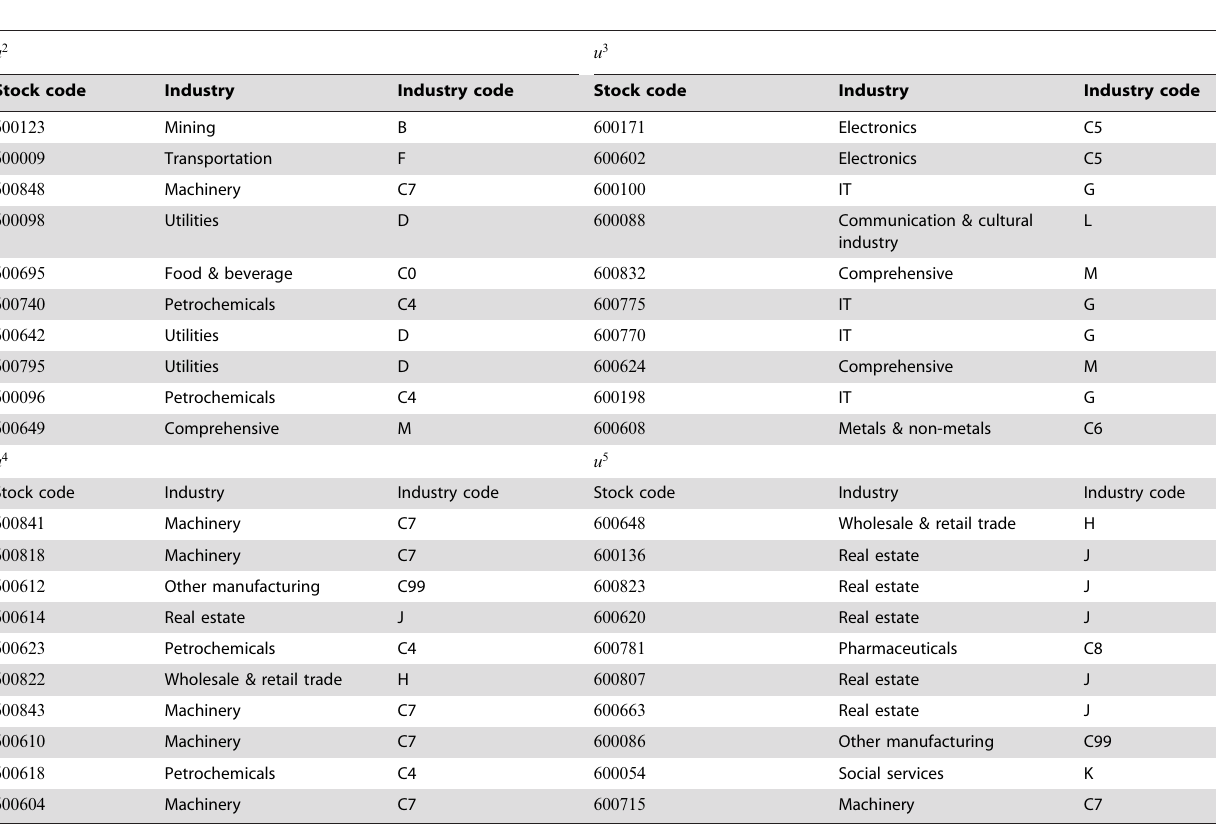
Table 3. Largest ten components of deviating eigenvectors in period from 02/04/2003 to